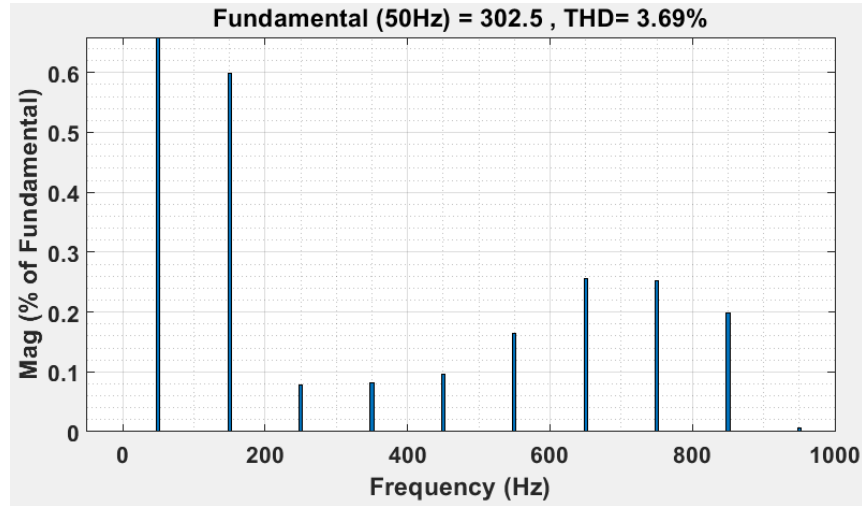
Figure 11. Performance of fast Fourier transform analysis.